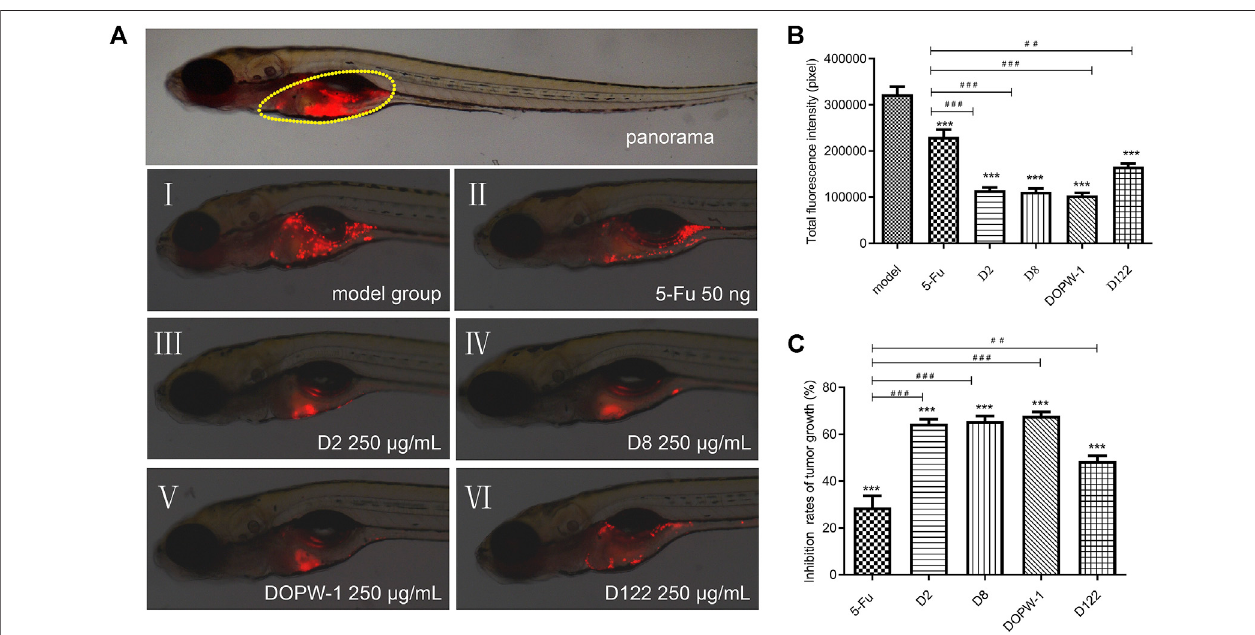
FIGURE 1 | Inhibitory effect of polysaccharides of different Mw derived from D . of fi cinale stems in a zebra fi sh xenograft model. (A) Red fl uorescence represents a tumor area. (B) Fluorescence intensity of the tumor xenograft model. (C) Quanti fi cation of the inhibition of tumor growth. Data are expressed as the mean ± SEM. *** P < 0.001 for each group vs . the model group; ## P < 0.01 and ### P < 0.001 for each group vs . the 5-Fu group.